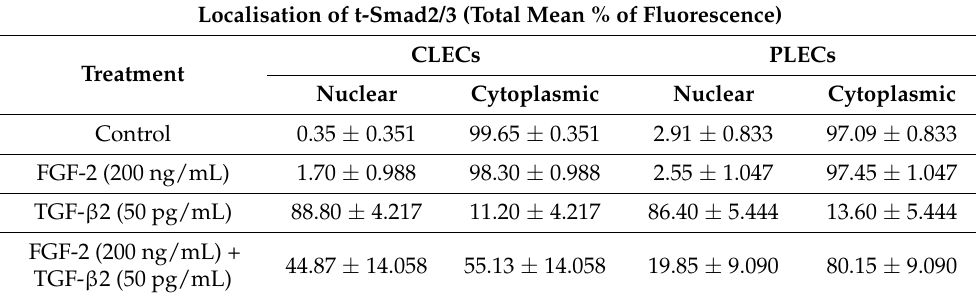
Table 2. Nuclear vs. cytoplasmic localisation of t-Smad2/3 in CLECs and PLECs. Localisation of t-Smad2/3 (Total Mean % of Fluorescence)